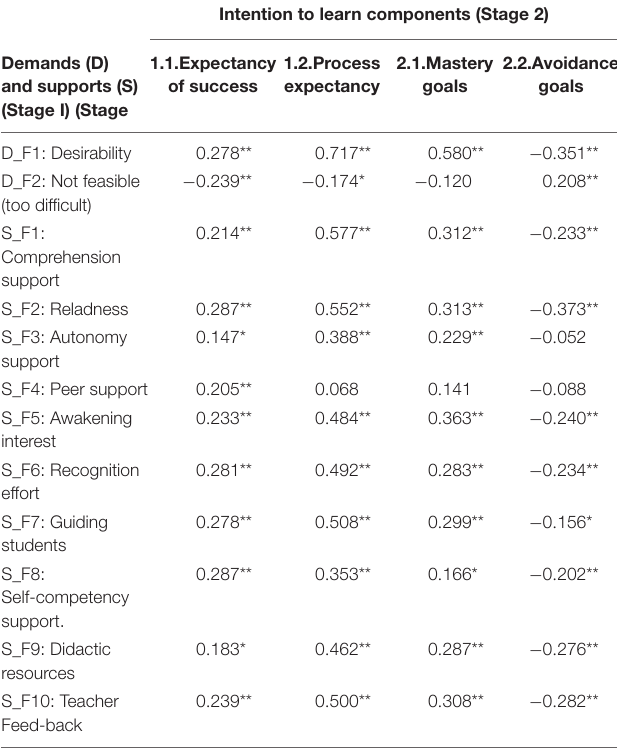
TABLE 5 | Correlation between demands-supports and anticipatory cognitive motivators. Intention to learn components (Stage